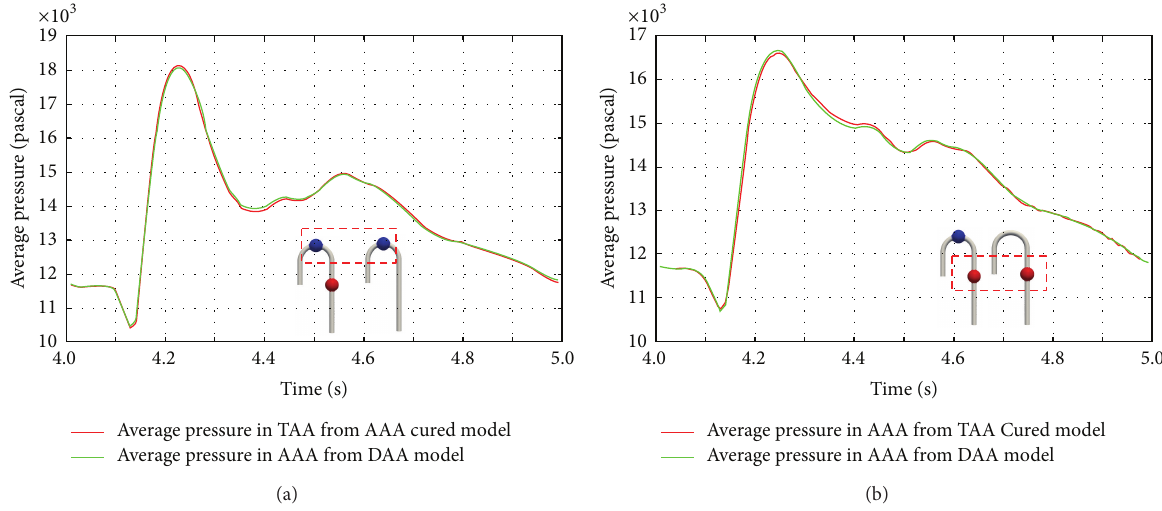
Figure 8: Pre- and post-first-surgery average pressure change in aneurysms: (a) average pressure comparison in TAA, (b) average pressure comparison in AAA.